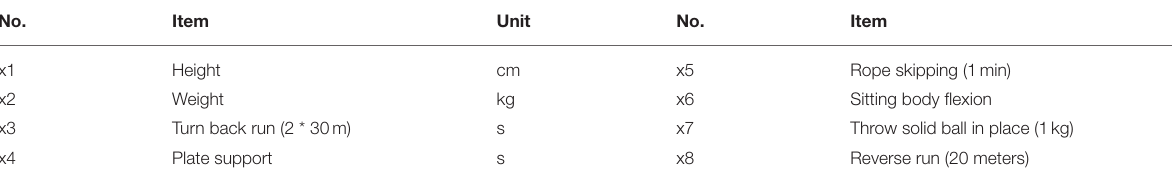
TABLE 1 | Motor performance scale.